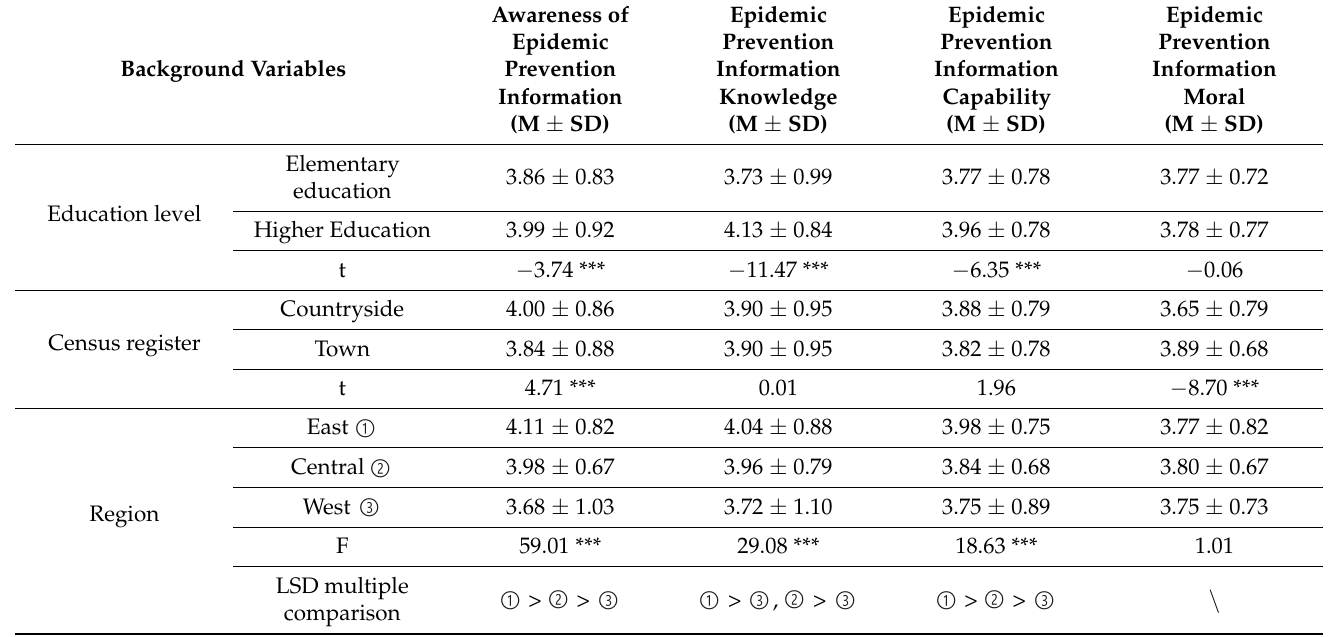
Table 2. Heterogeneous test in different dimensions of epidemic prevention information literacy.